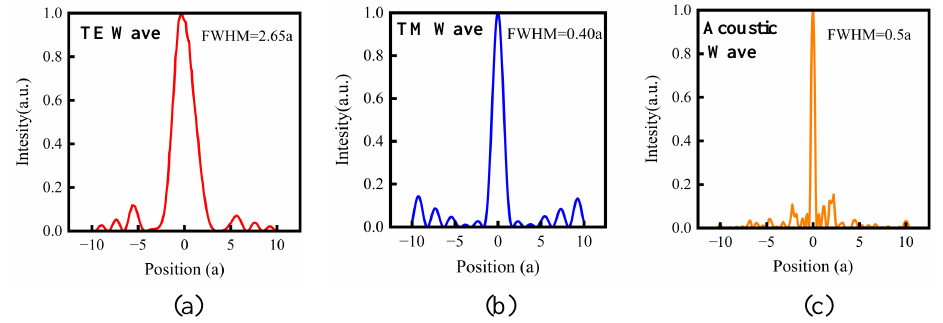
Figure 6. Intensity distributions of images in the cross-section along the x direction for ( a ) TE mode, ( b ) TM mode, and ( c ) acoustic mode. FWHMs for the three modes are 2.65a, 1.48a, and 0.5a,